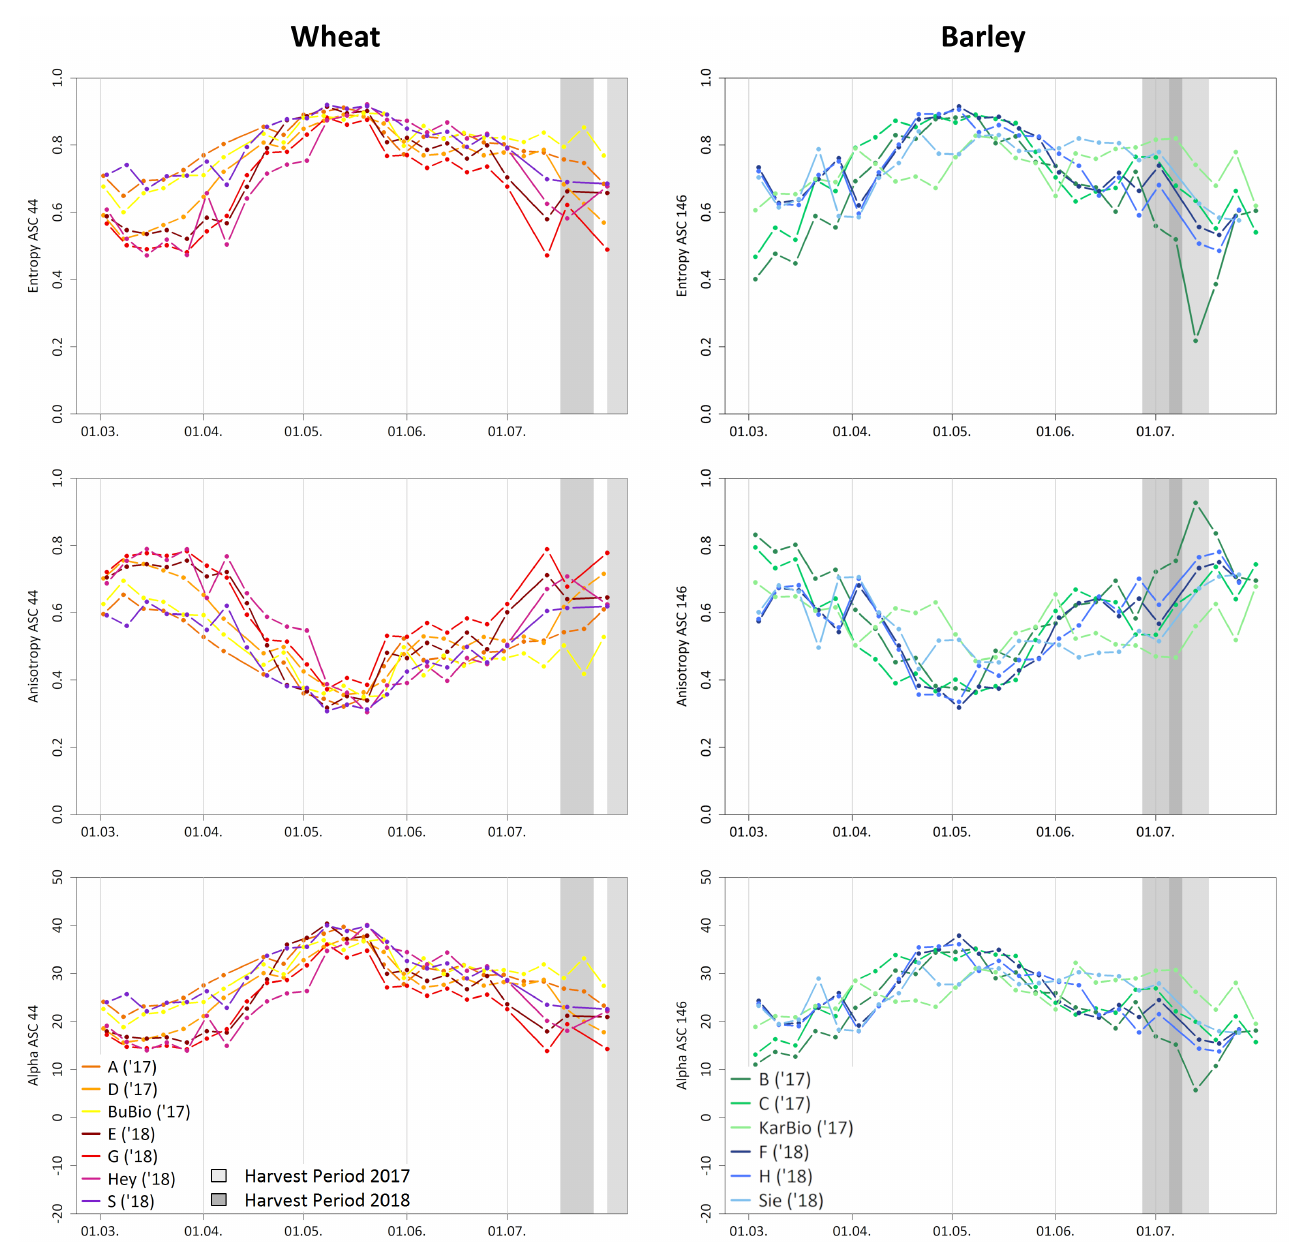
Figure 9. Temporal development of decomposition parameters entropy, anisotropy, and alpha for all observed wheat fields ( left ) and all observed barley fields ( right